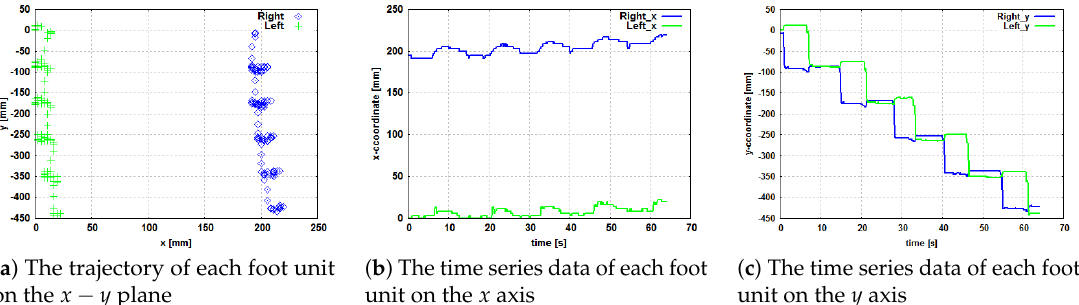
Figure 15. The graph of the normal locomotion experiment. ( a – c ) are the graphs of numerical data related to the normal locomotion between five steps. The origin was set on the initial left foot unit